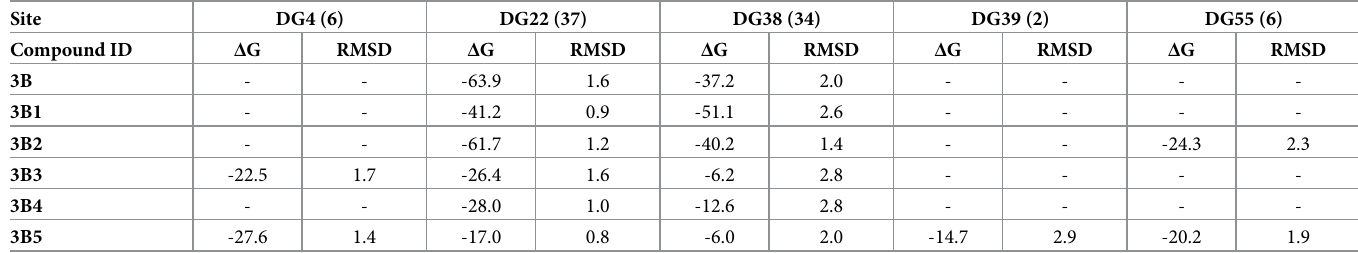
Table 2. Tabulated free energy results from 5 ns MD simulation. Free energies, if available, are given for each compound at each docking site. The corresponding com- pound RMSD is also given as an indication of change from initial docked conformation at the start of simulation. The values reported are for the largest negative free energy value for each ligand/conformer/tautomer at each site. The parenthesis next to docking site indicates the total number of simulations at each site (i.e., 37 different combinations of derivatives with favorable docking scores were simulated at site DG22). Instances of missing values indicates that either there was no docking solution or that the docking score indicated an unfavorable